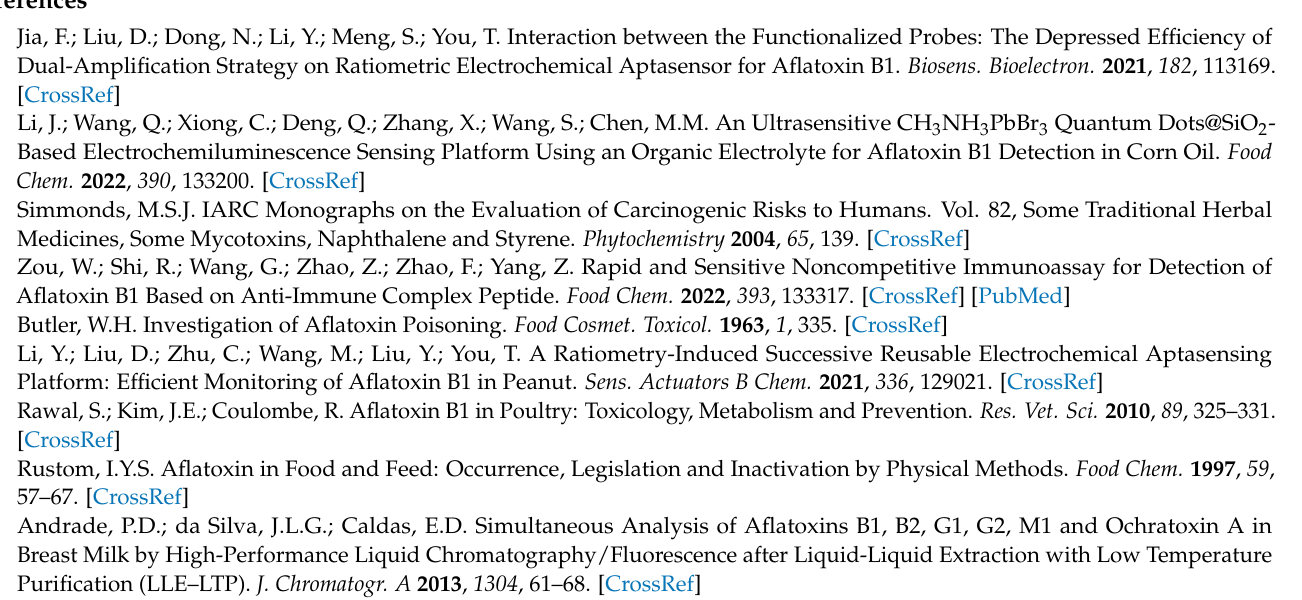
Apt-Au/SSE electrode. Figure S2: FESEM micrographs of the pristine CF in different scales (a) 100 µ m, (b) 10 µ m. Figure S3: FESEM micrographs of (a) SSE and (b) PS-COOH. Figure S4: DPV responses of the biosensor recorded in 10 mM H 2 O 2 with varying concentrations of AFB 1